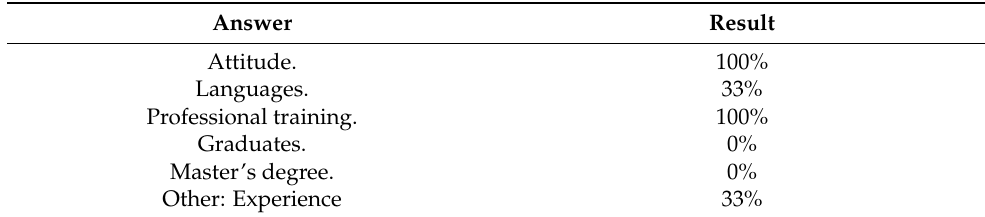
Table 7. When selecting candidates with disabilities, what profile is required (skills, training level, etc.)? (Check one or more options).